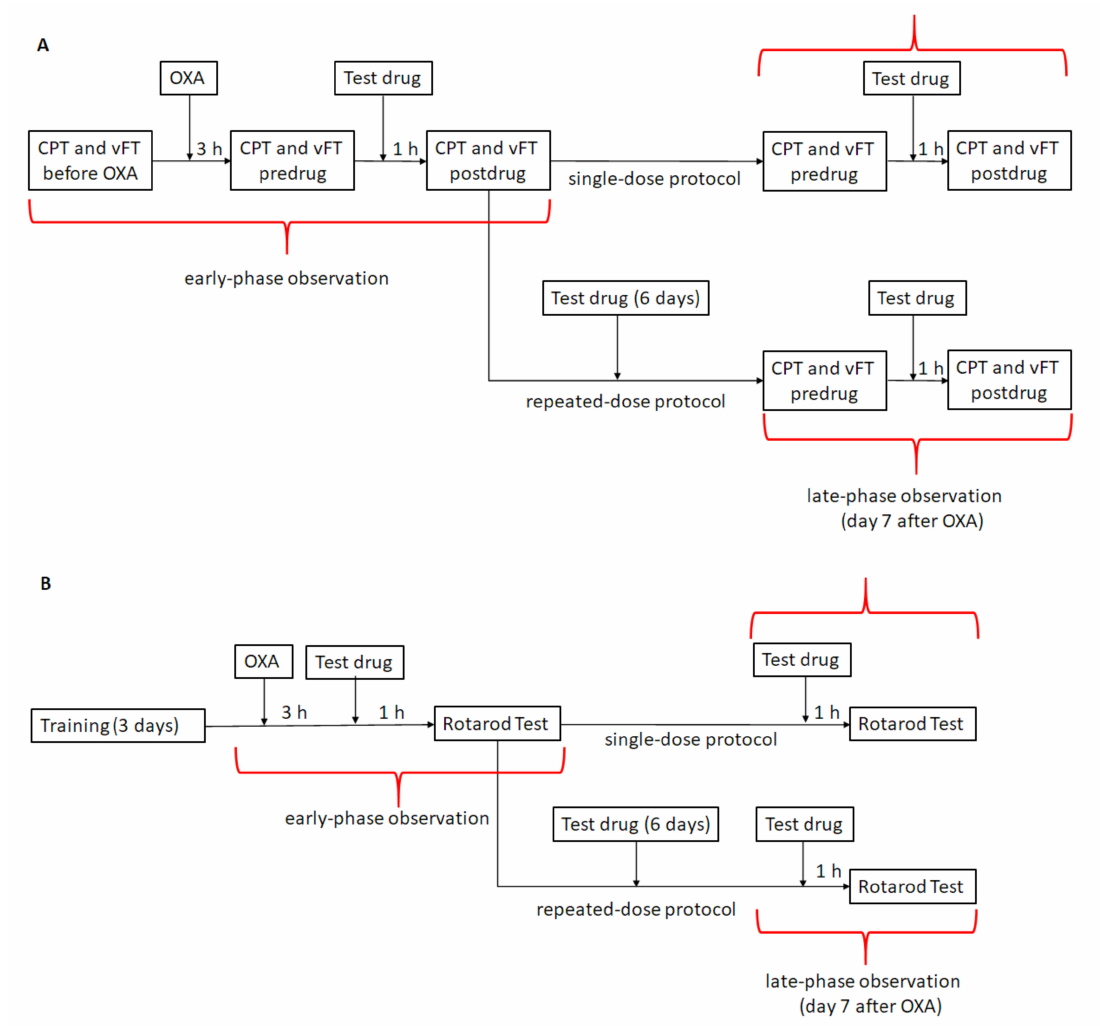
Figure 1. Schema showing drug administration and in vivo testing protocols used in the present study. ( A ) The intervention protocol used to measure the effects of single-dose or repeated-dose minocycline, ambroxol and duloxetine used alone or in combination on tactile allodynia in the von Frey test and cold hyperalgesia in the cold plate test in oxaliplatin-treated mice. ( B ) The protocol used for the measurement of the impact of these drugs on animals’ motor coordination assessed in the rotarod test. Abbreviations: CPT—cold plate test; vFT—von Frey test;